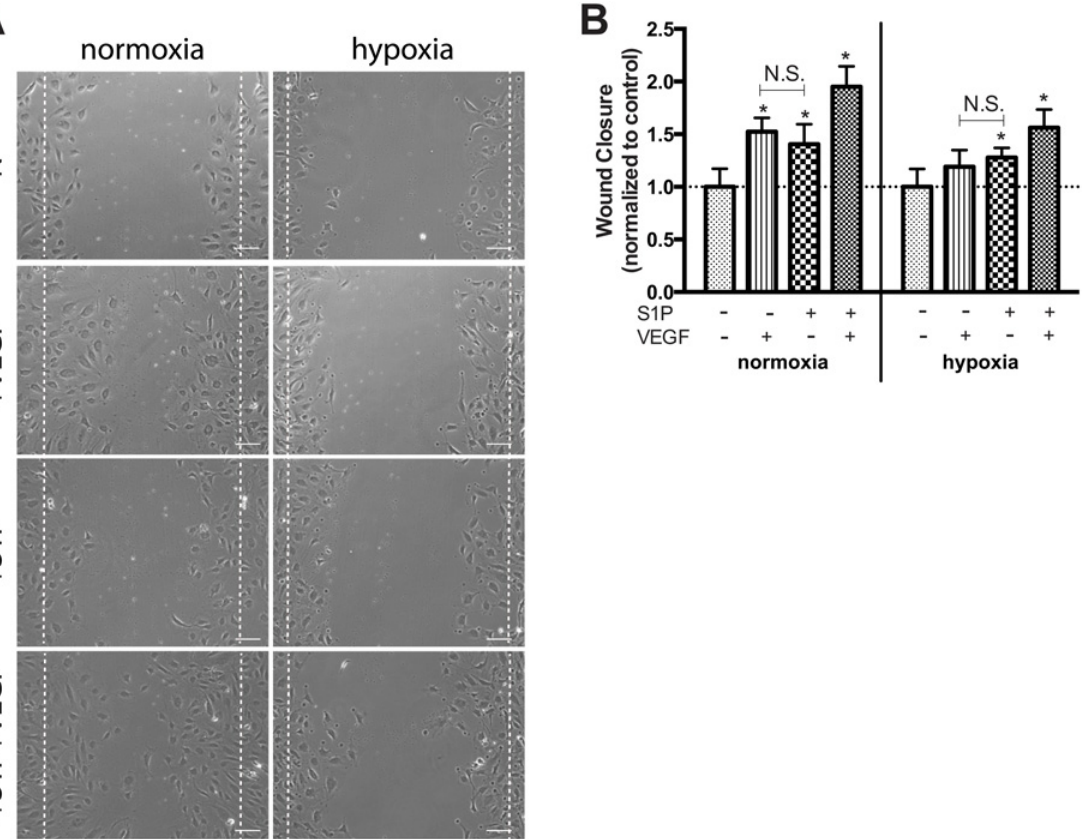
Fig 3. Combination therapy enhanced S1P-induced motility under both normoxia and hypoxia. OEC motility was assessed in response to 1.0 μ M S1P and/or 50 ng/mL VEGF for 12h under normoxia and hypoxia (A). S1P and VEGF combined resulted in accelerated wound closure compared to either stimuli alone under both normoxia and hypoxia (B). Data are mean ± SD (n = 5) and normalized to the average untreated control values for either normoxia or hypoxia (indicated by the dashed line) accordingly. An asterisk indicates statistically significant differences (P < 0.05) between conditions in normoxia or hypoxia respectively and N.S. displays no statistically significant difference between